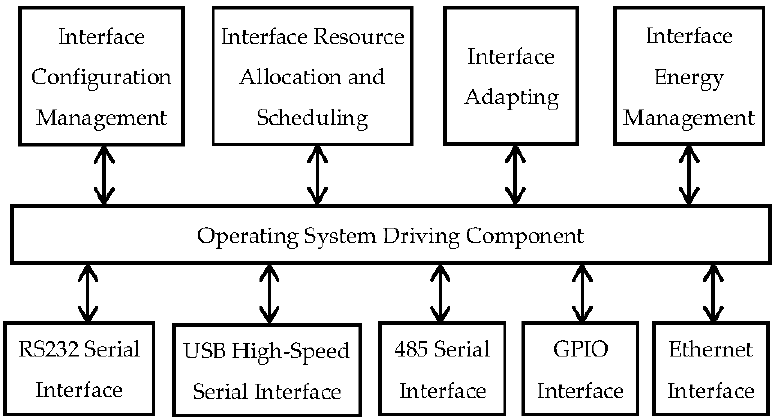
Figure 3. The integrated module of ports with multiple functions.